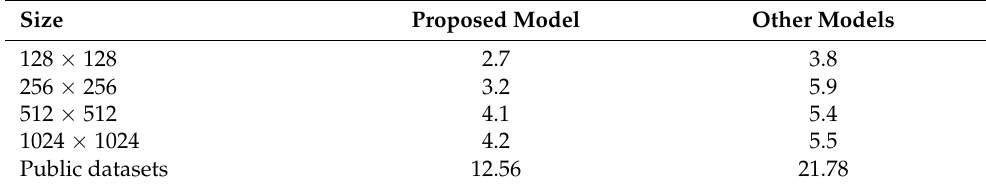
Table 6. Expected performance—compression computing times (in ms) compared with those of other models.